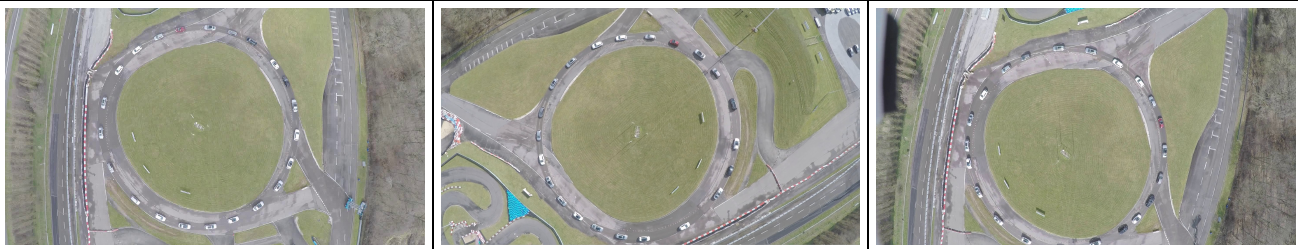
Figure 5. Images extracted from the five-minute long C2 sequences, taken approximately 30 s apart. The left image is the reference